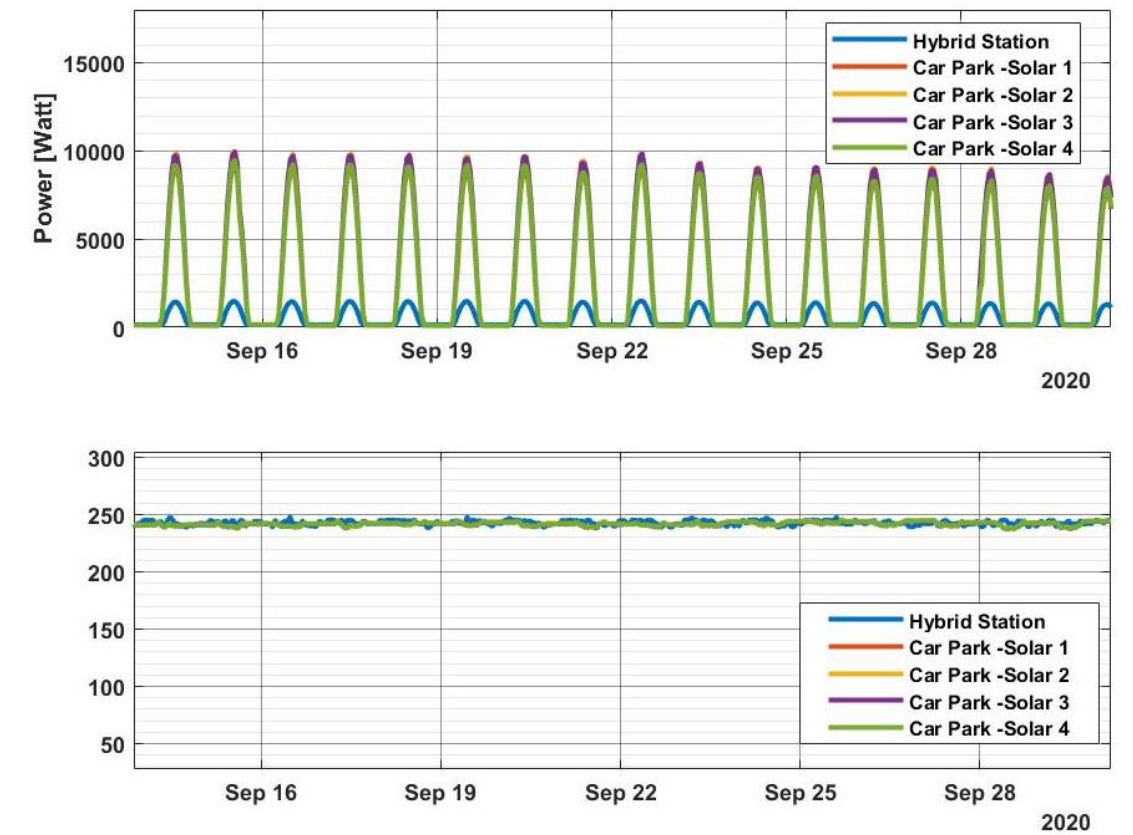
Figure 23. Power ( top ) and voltage levels ( bottom ) measured from the inverters at the Hybrid Station and Solar Cark Park.